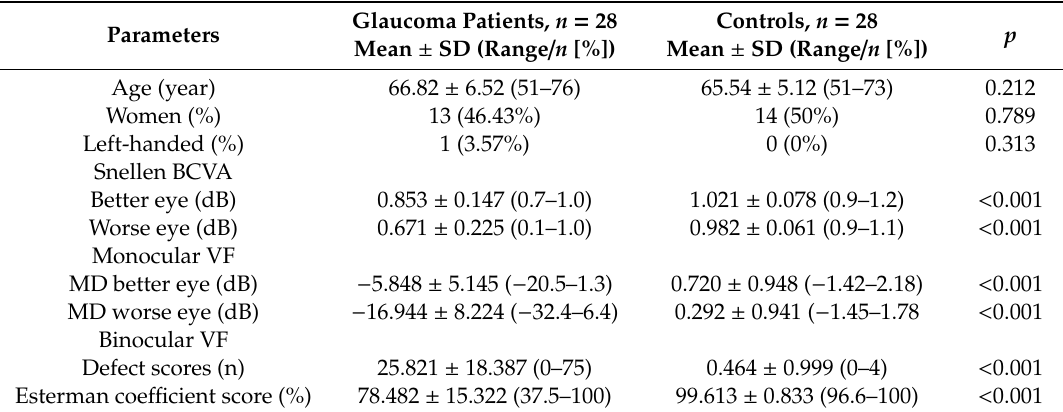
Table 1. Demographic and clinical characteristics of study participants.